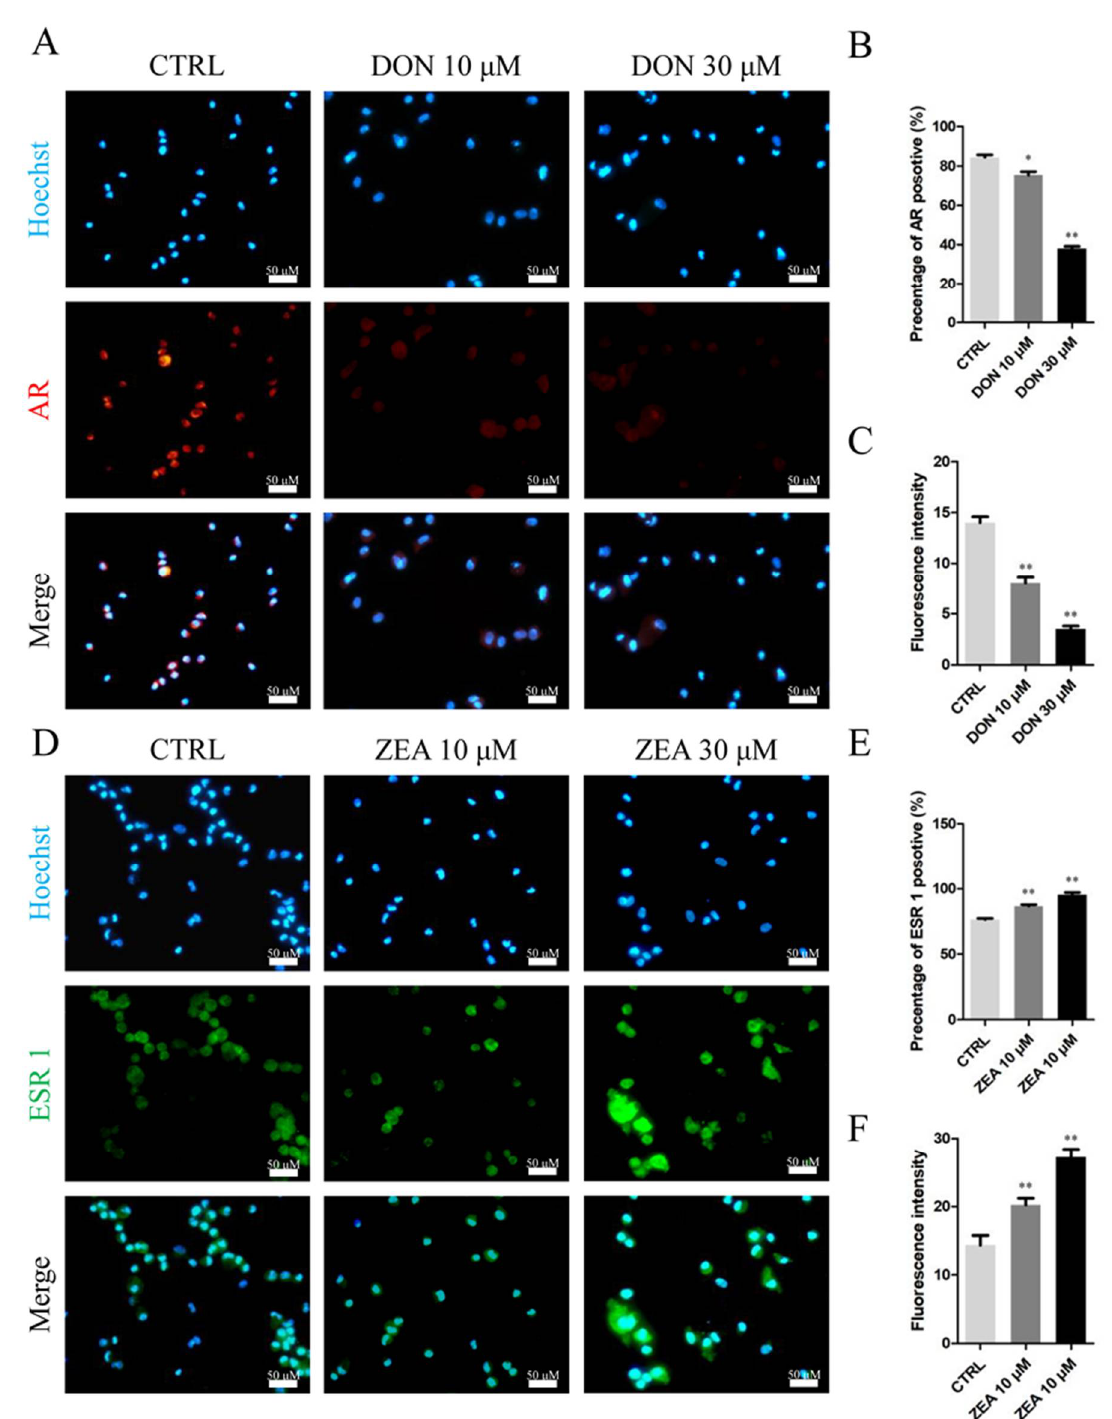
Figure 10. Immunofluorescence assay probing the expression of phosphor- AR ( A ) and ESR1 ( D ) proteins in SCs in the DON and ZEA treatment groups. The percentages of positive cells ( B , E ) and fluorescence intensity ( C , F ) were analysed. Bar indicates 50 μm. Data are presented as the means ± SD. * p < 0.05; ** p < 0.01.